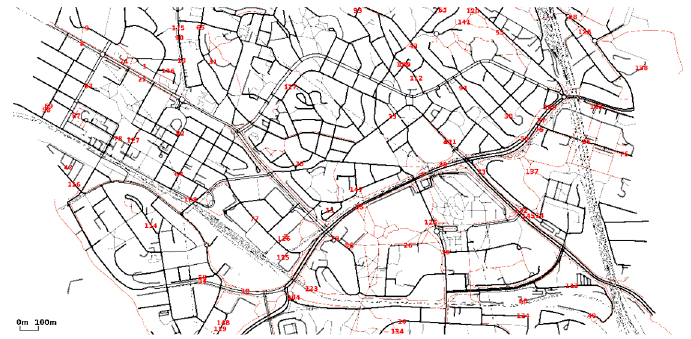
Figure 1 2 . Map for the simulations. Figure 12. Map for the simulations.